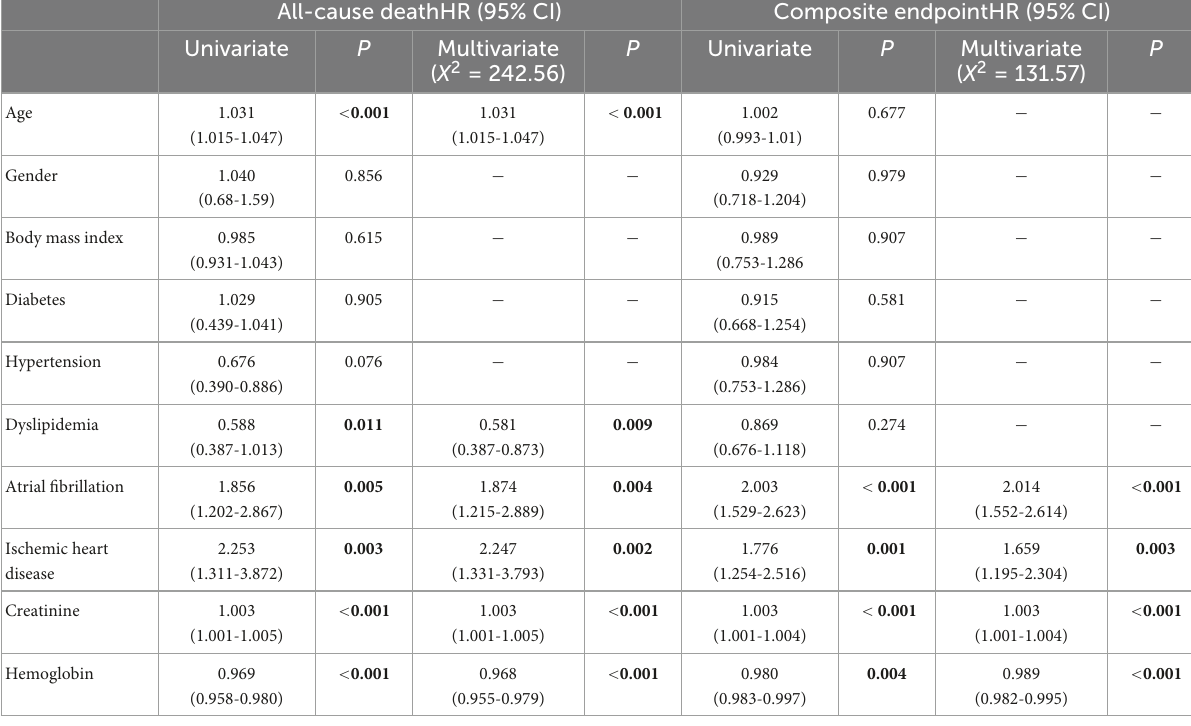
TABLE 2 Demographic and clinical parameters associated with both all-cause death and the composite endpoint of death and cardiac hospitalization.